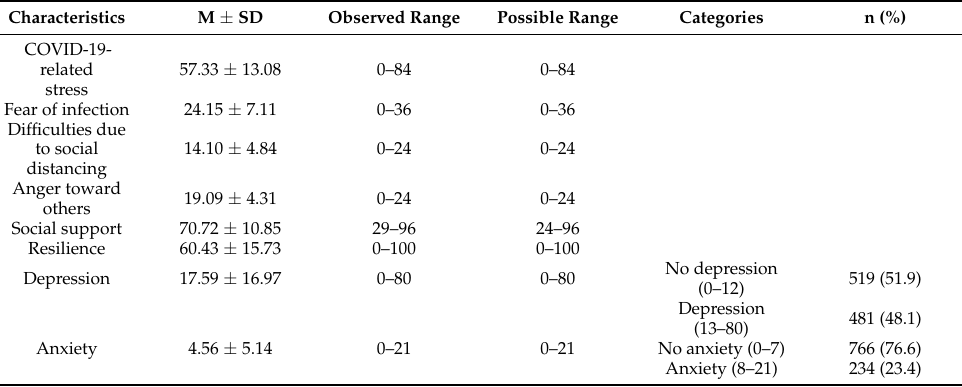
Table 2. Levels of COVID-19-related stress, social support, resilience, depression, and anxiety (N =